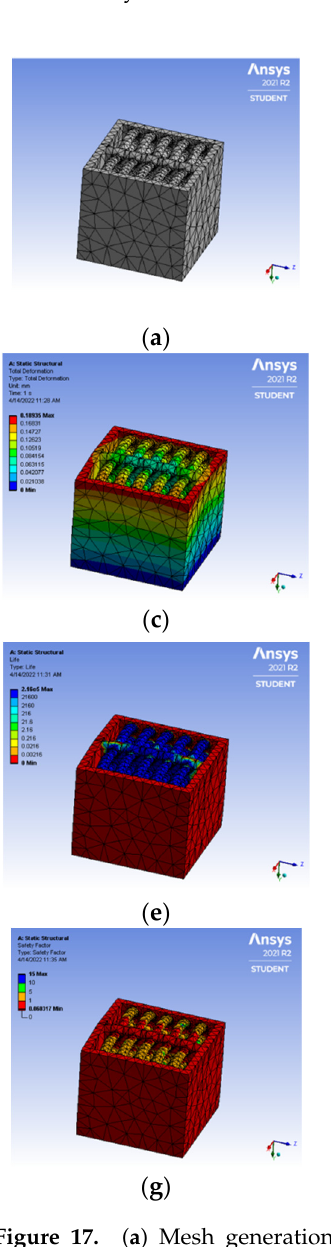
Figure 16. ( a ) Mesh generation; ( b ) Loads and boundary conditions; ( c ) Total deformation; ( d ) Von mises stress; ( e ) Life cycle; ( f ) Damage; ( g ) Factor of safety; ( h ) Biaxiality indication.